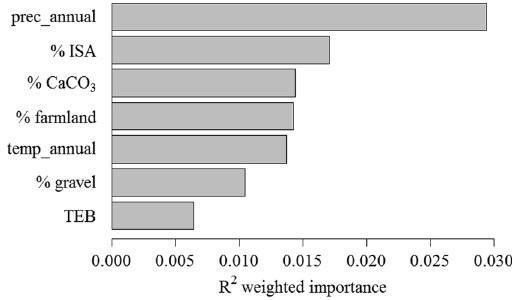
Figure 3. Overall R 2 weighted importance of human land use and natural environmental variables for species composition of benthic diatom assemblages in tributaries of the Three Gorges Reservoir. For the full names of each variable, please see Table